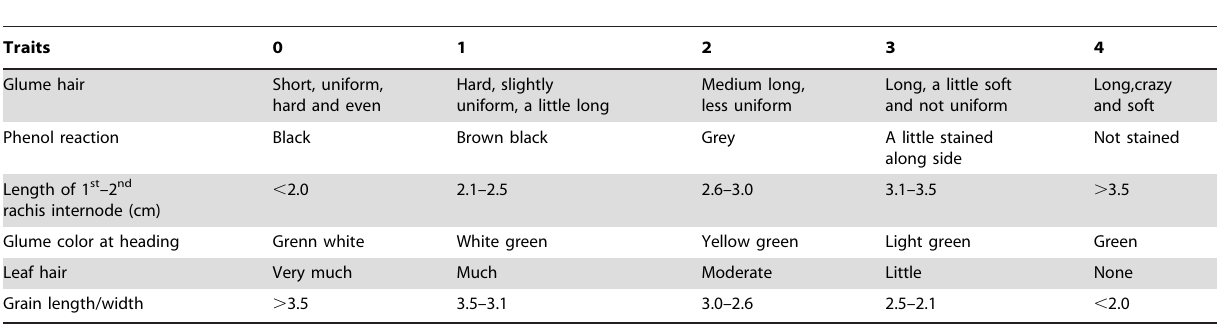
Table 1. The morphological traits and their scoring standards of the Cheng’s index method.